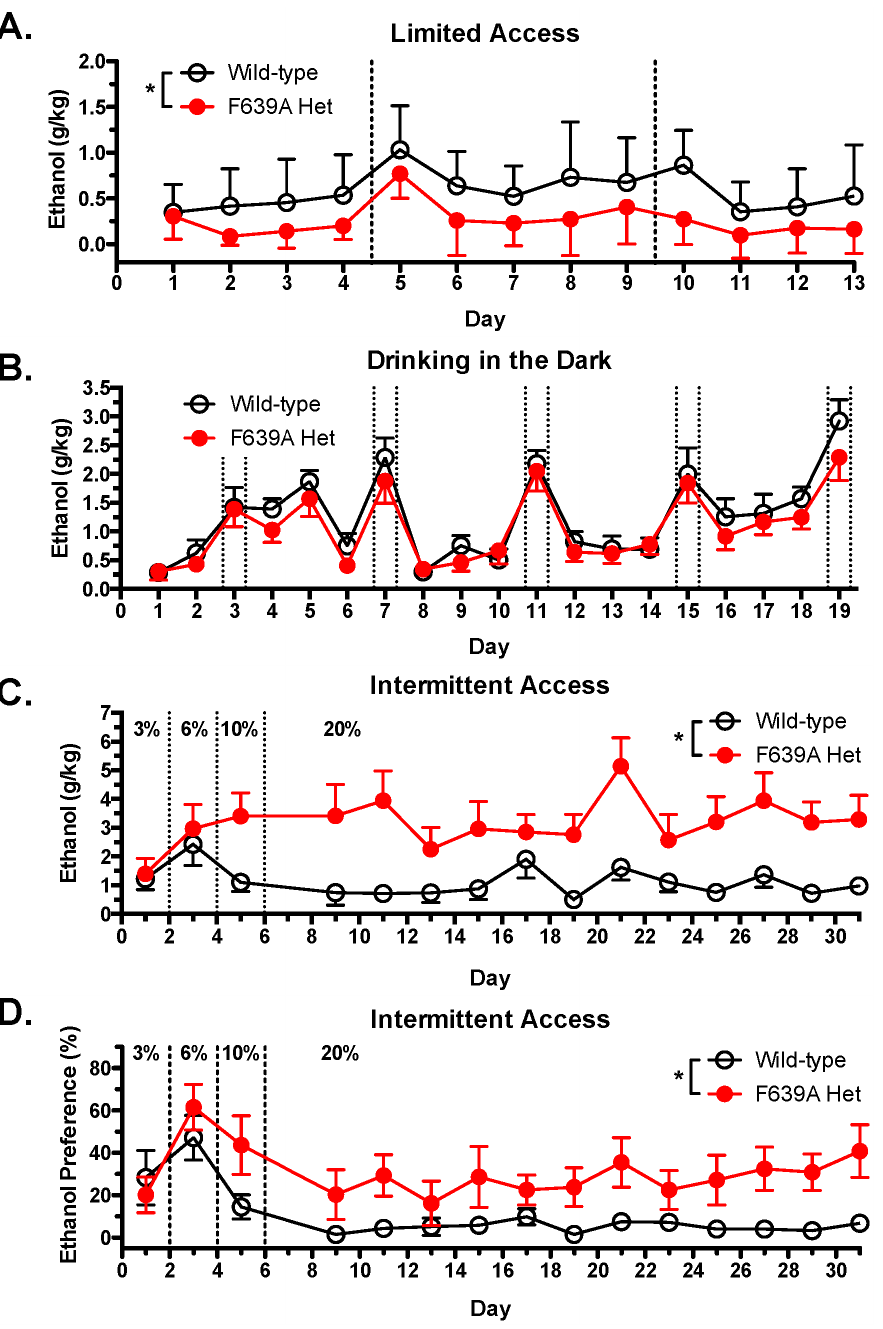
Figure 7. F639A Het mice show altered ethanol consumption than wild-type mice in short-access and long-access drinking paradigms. ( A ), Ethanol intake (mean 6 SEM) in wild-type and F639A Het mice during 2 h limited-access to 15% (v/v) ethanol or water (n=8 for each group). Symbol (*): indicates main effect of genotype (* p , 0.05, mixed ANOVA). ( B ), Ethanol intake (mean 6 SEM) in a limited-access DID model in wild-type and F639A Het mice. Mice had access to one bottle containing 20% (v/v) ethanol 3 h into their dark cycle for 2 h and 4 h sessions (n=11– 12 for each group). Dotted lines indicate 4 h sessions. ( C ), Ethanol intake (mean 6 SEM) in wild-type and F639A Het mice during intermittent 24 h access to ethanol or water (n=10–11 for each group). Ethanol concentrations were ramped from 3, 6, 10% and maintained at 20% (v/v) ethanol. Symbol (*): indicates main effect of genotype (* p , 0.05, mixed ANOVA). ( D ), Percent preference for ethanol solution over water-bottle choice in a subset of animals from intermittent access study (n=6 from each group). Symbol (*): indicates main effect of genotype (* p , 0.05, mixed ANOVA). Values are mean 6 SEM. doi:10.1371/journal.pone.0080541.g007 Unlike GluN2A null mice, germline deletion of either GluN1 or mouse to reduce GluN2B expression in forebrain, dorsal and GluN2B subunits is lethal [30,42]. Badanich et al [43] circum- ventral striatum, amygdala and BNST of adult mice. These mice vented this problem by using a Cre-mediated conditional KO had higher basal levels of locomotor activity that was further